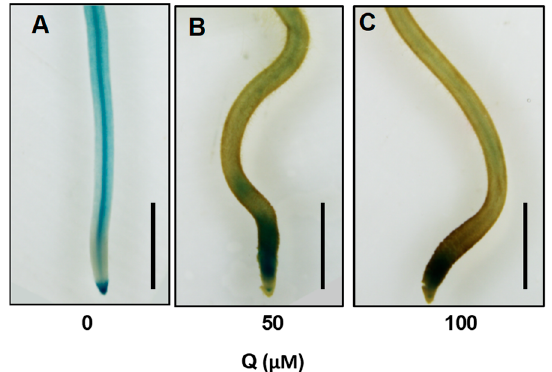
Figure 8. Quercetin treatment affects DR5:GUS expression patterns. Three-day-old DR5:GUS transgenic rice seedlings grown in a liquid medium were treated with quercetin for another two days. The roots were then stained in a X-gluc buffer for 12 h at 37 ◦ C in the dark. The DR5:GUS expression patterns of the untreated ( A ), 50 µ M of quercetin ( B ), and 100 µ M of quercetin ( C ) plants are presented. Bars = 1 mm.